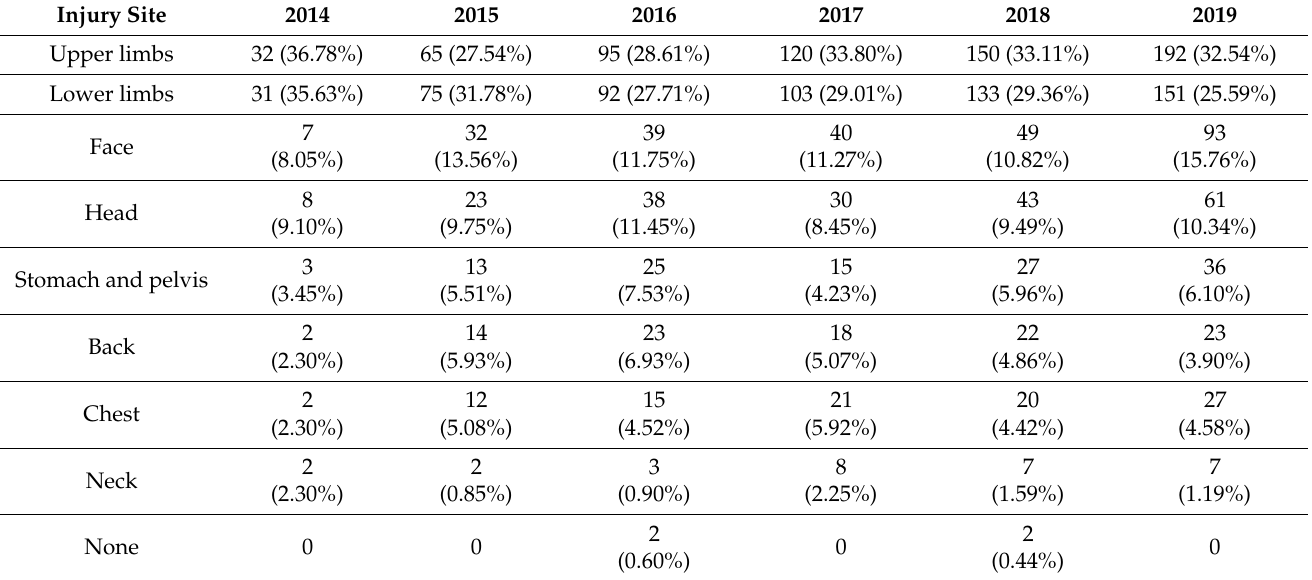
Table 2. Anatomic site of injury by year.